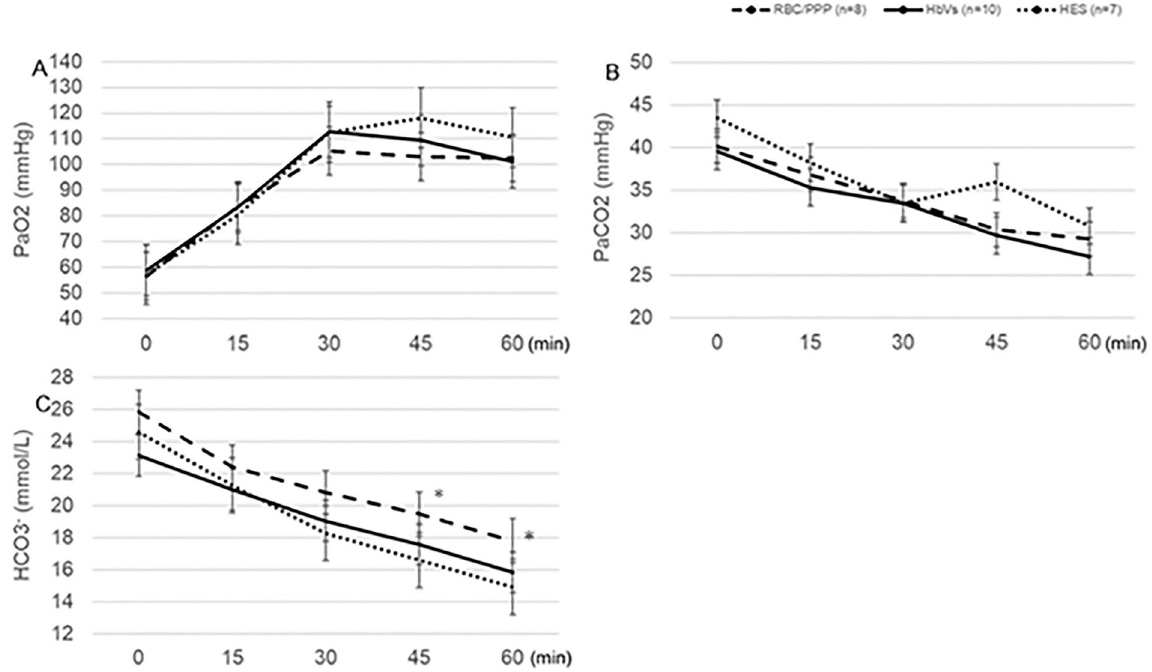
Figure 4. Changes in the levels of ( A ) PaO 2 , ( B ) PaCO 2 , and ( C ) HCO 3 . ( A ) There are no significant differences in the PaO 2 levels among all the groups throughout the experiment. ( B ) There are also no significant differences in the PaCO 2 levels among all groups throughout the experiment. ( C ) At 45 and 60 min, the HCO3 - level is significantly higher in the RBC/PPP group than in the other groups. *P < 0.05, value significantly different from the other groups. Data shown are the mean ± standard deviation. HbV hemoglobin vesicles, HES hydroxyethyl starch, RBC/PPP red blood cells with platelet-poor